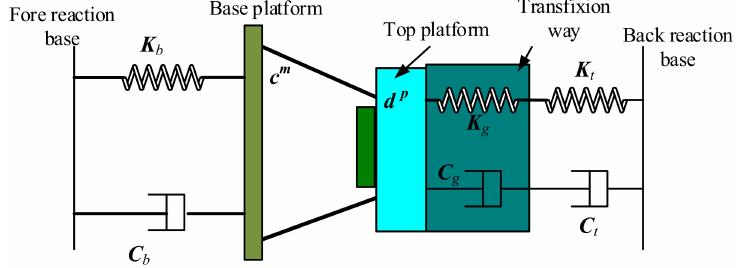
Figure 2. Model of comprehensive test system for train end relationship.